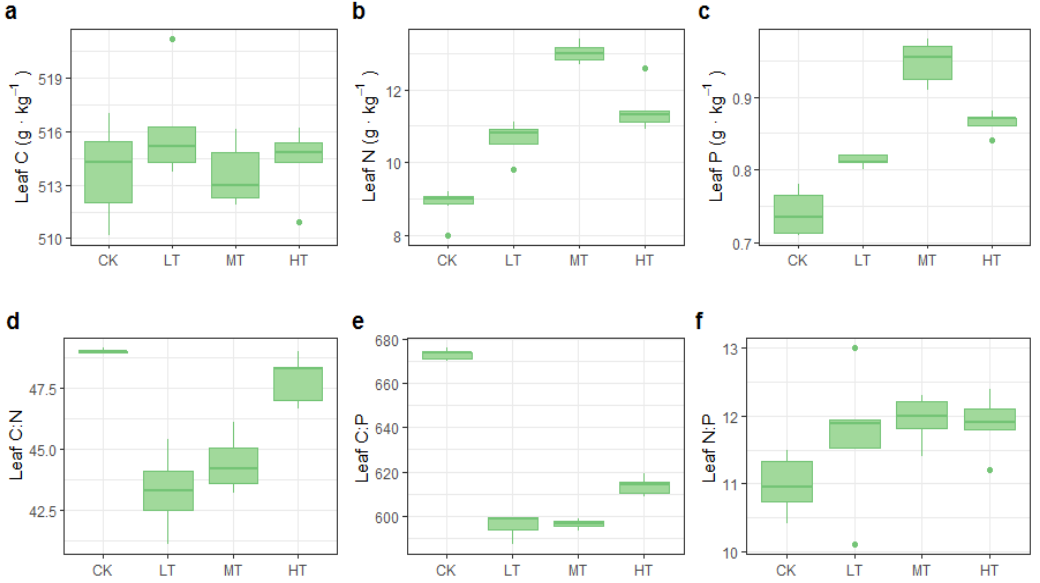
Figure 2. Changes in leaf C, N, and P content ( a – c ) and leaf C:N, C:P, and N:P ratios ( d – f ) among four thinning